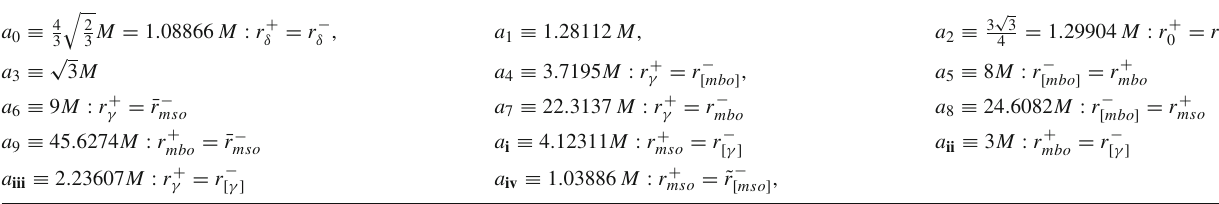
Table 2 Notable spins in the Kerr NS spacetime. Radii r , defining the spin sets are in Table 1. Radii r ± Fig. 1